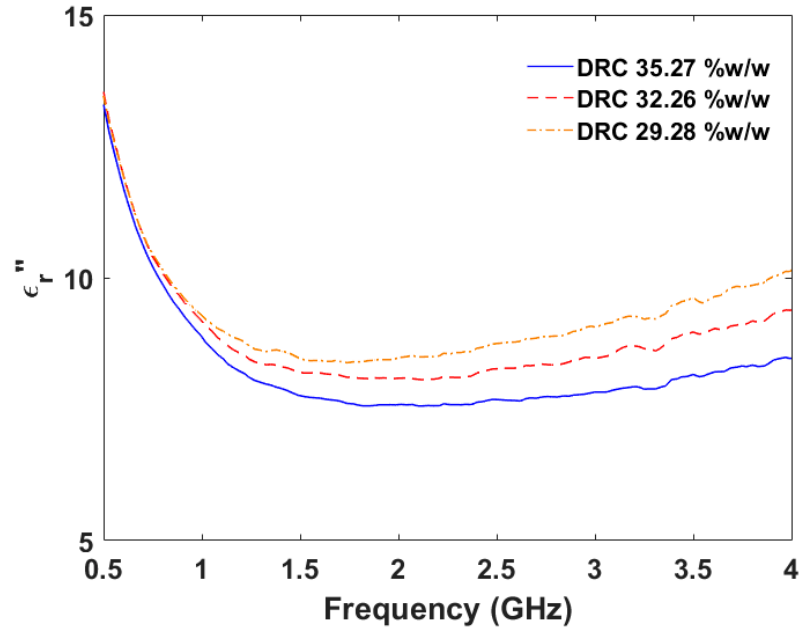
Figure 20. The imaginary part of complex relative permittivity of natural latex samples with different DRCs in the frequency range of 0.5–4.0 GHz at the temperature of 25 °C.